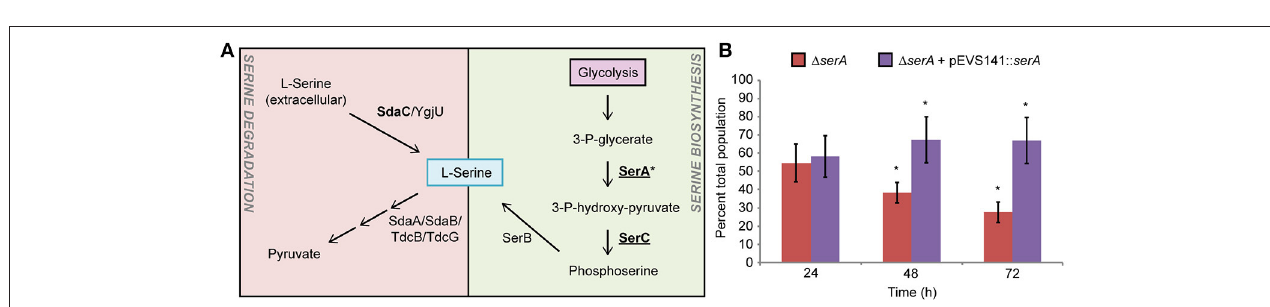
FIGURE 3 | Serine biosynthesis is required for S. enterica plant colonization. (A) Serine network proteins were detected in proteomic screens of S. enterica during colonization of mice (bolded, Steeb et al., 2013) and growth in association with alfalfa seedlings (underlined, Kwan et al., 2015). S. enterica SL1344 1 serA was reduced in competitive fitness in alfalfa seedling colonization (B) . Bars show the mean percent of the total population comprised of 1 serA following a 1:1 co-inoculation with the isogenic WT. *, statistically different from 50% (Student’s t -test, n = 3, p < 0.05).